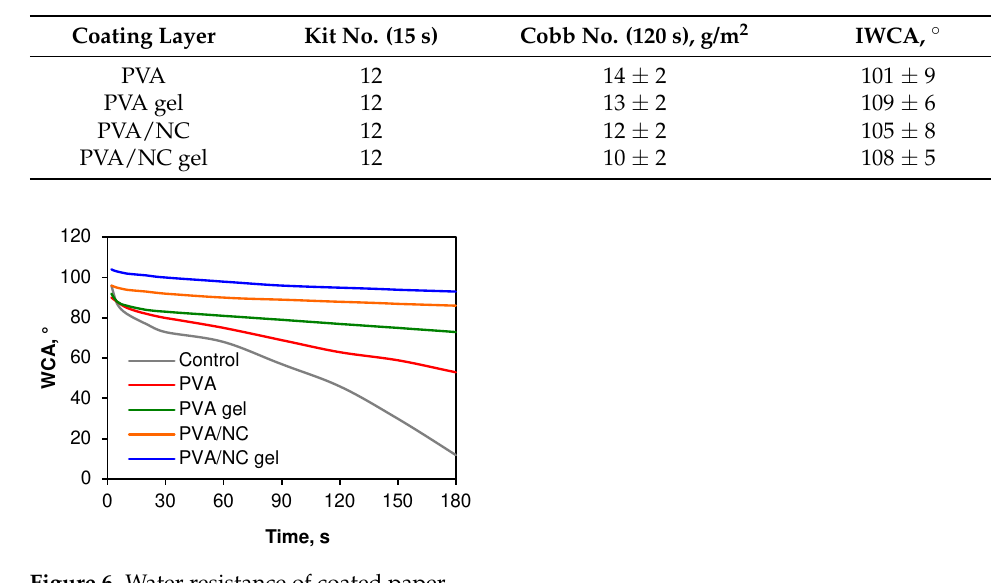
Figure 6. Water resistance of coated paper.